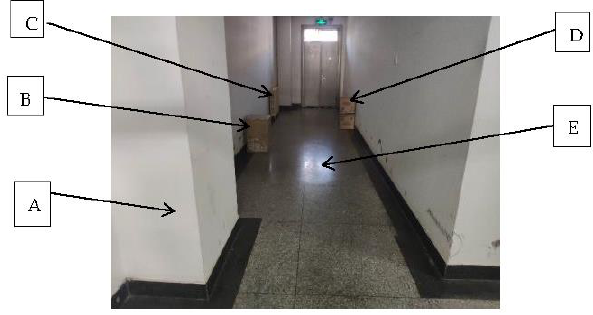
Figure 23. Actual test environment.